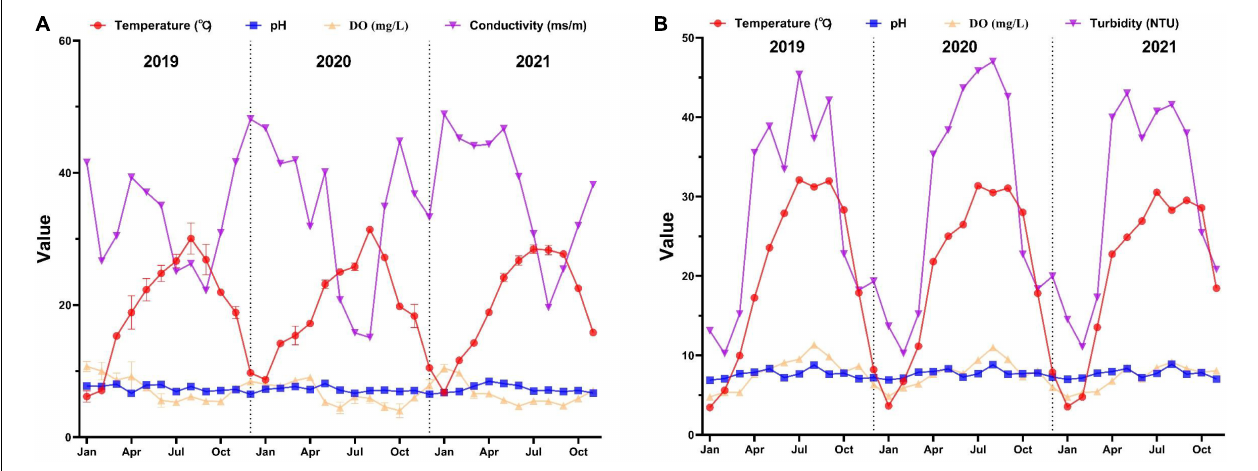
FIGURE 2 | Water quality of South (A) and North (B) Taihu